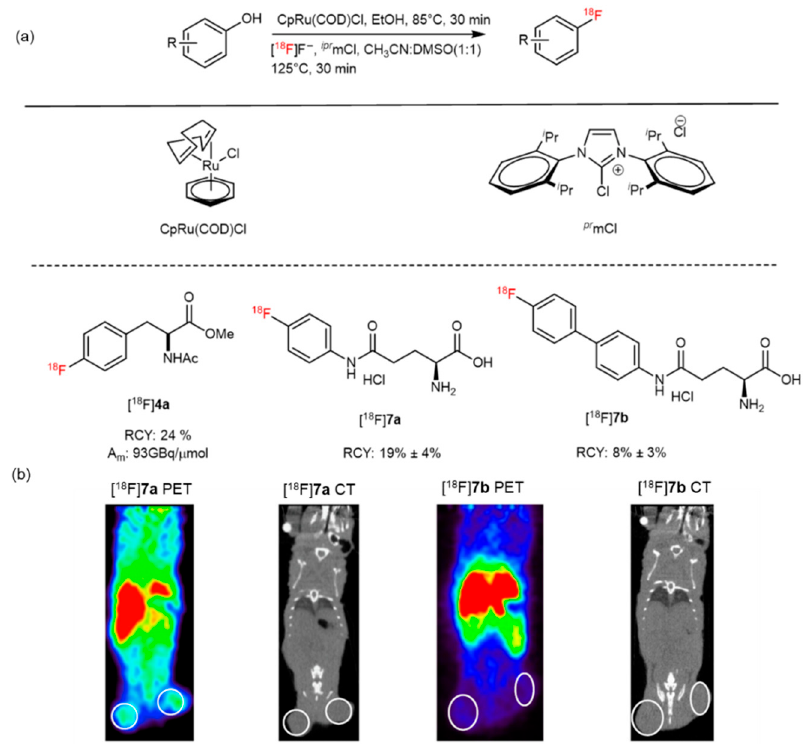
Figure 9. ( a ) 18 F-fluorophenylalanine derivatives, [ 18 F] 7a and [ 18 F]7 b, were synthesized from an iPr ImCl-mediated deoxyfluorination reaction. Modified from Beyzavi et al. [45]. ( b ) Micro PET and CT images of [ 18 F] 7a and [ 18 F] 7b in PC-3 xenografts of a tumor-bearing mouse. Reproduced from ref. [46], Copyright 2020, with permission from Elsevier.